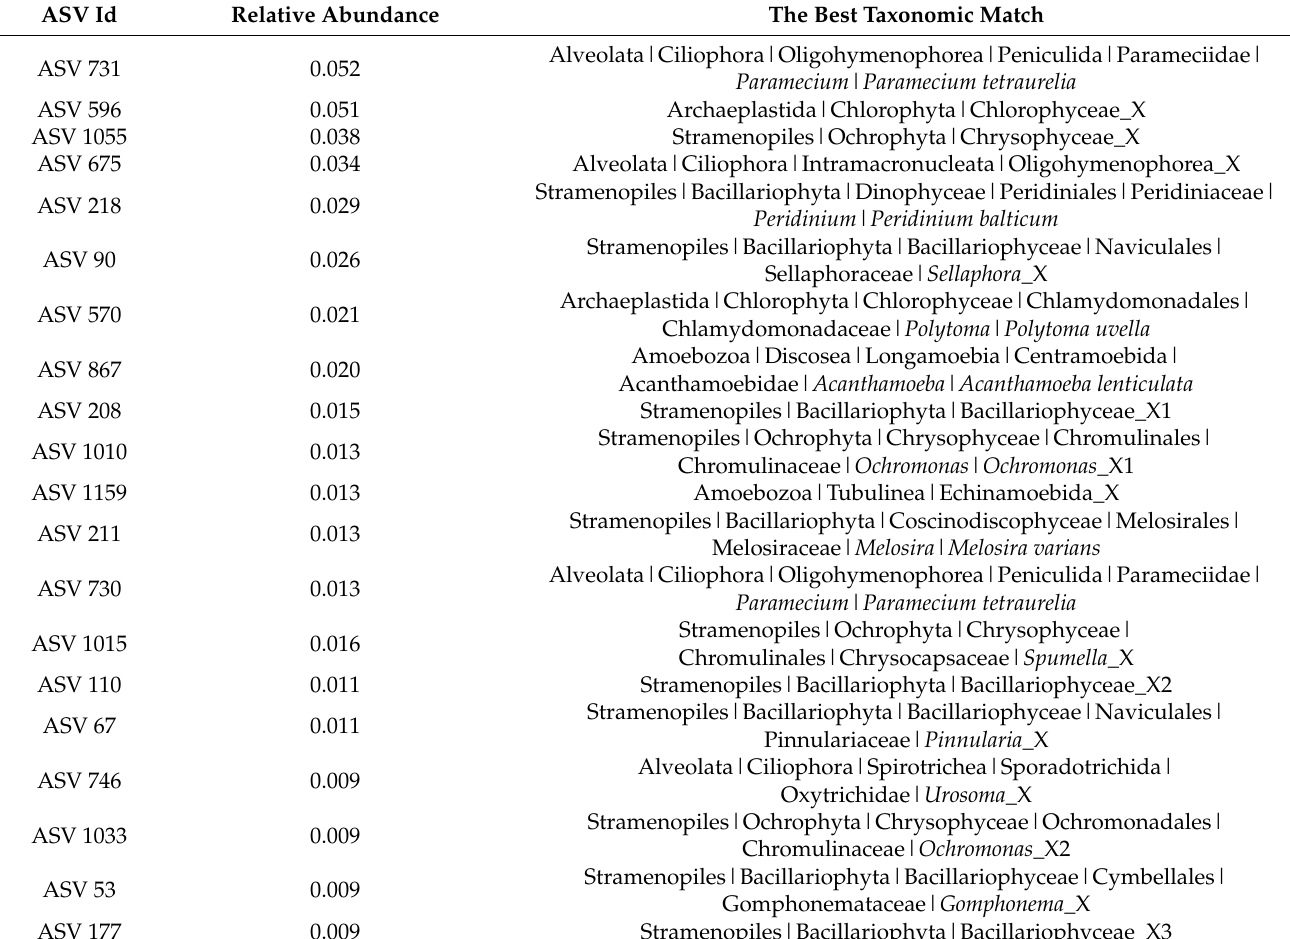
Table 1. Top 20 ASVs with relatively high abundance by combining all